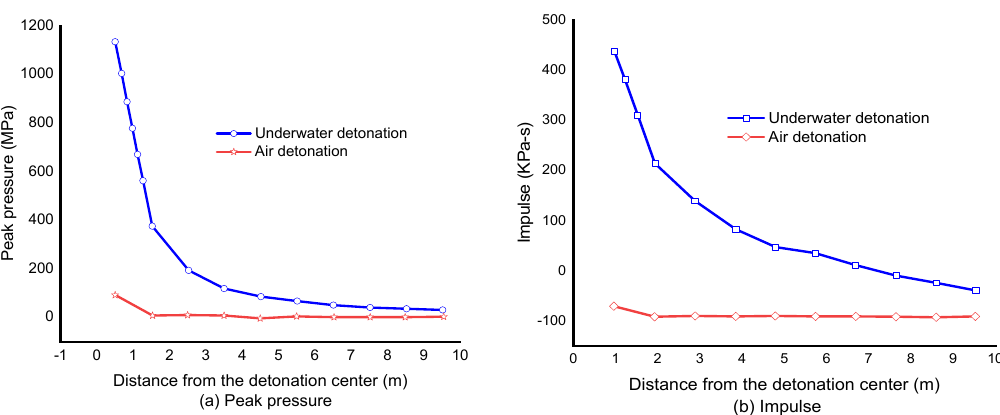
Figure 7. Comparison of peak pressure and impulse of underwater and air explosion shock waves.